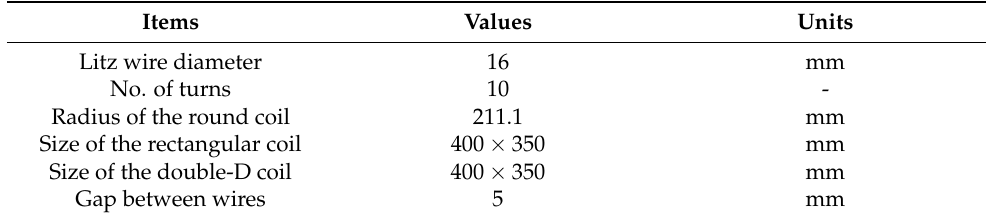
Table 2. The parameters for all three coil geometries. Items Values Units Litz wire diameter 16 mm No. of turns 10 - Radius of the round coil 211.1